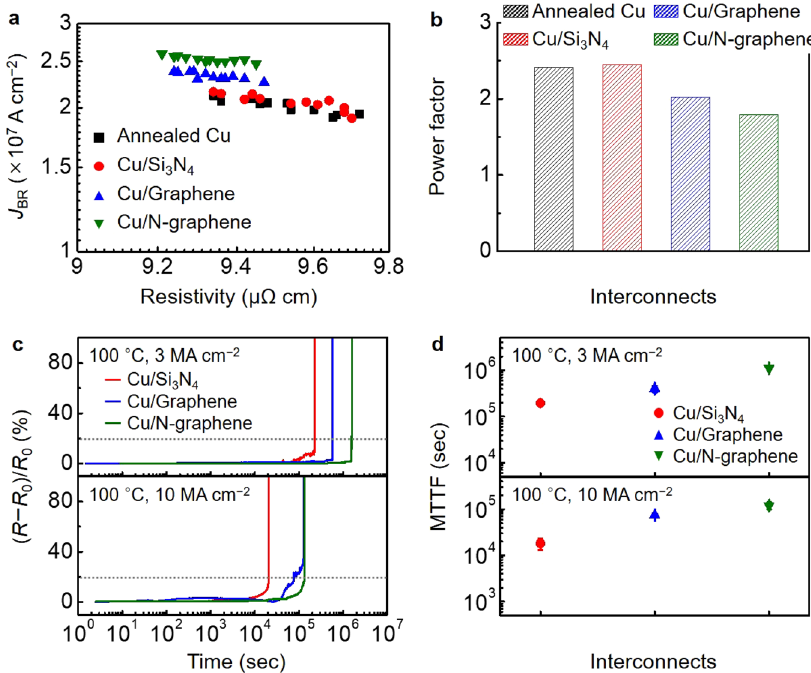
Fig. 3 The interconnect performance of graphene-capped Cu heterostructures. a J BR vs ρ plots b power factors of annealed Cu, Cu/Si 3 N 4 , Cu/Graphene and Cu/N-graphene interconnects. Power factors are calculated from Log( J BR ) vs Log( ρ ) plots of Supplementary Fig. 10. c ( R − R 0 )/ R 0 vs time curve and d failure time of Cu/Si 3 N 4 , Cu/Graphene and Cu/N-graphene interconnects measured at 100 °C under 3 and 10 MA cm − 2